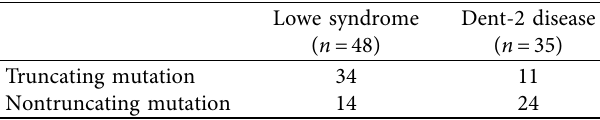
Table 3: The results of mutation type from Lowe syndrome and Dent-2